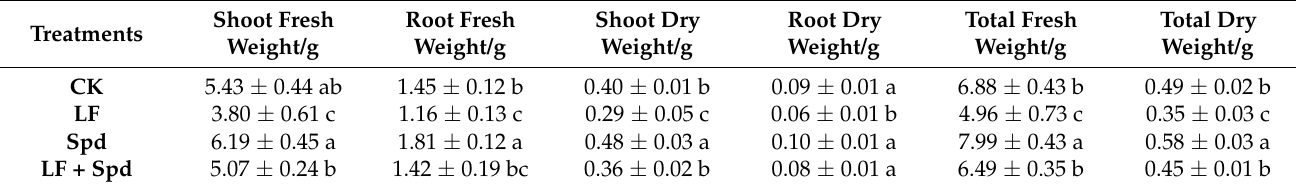
Table 2. Effects of exogenous Spd on tomato biomass under low-iron stress.